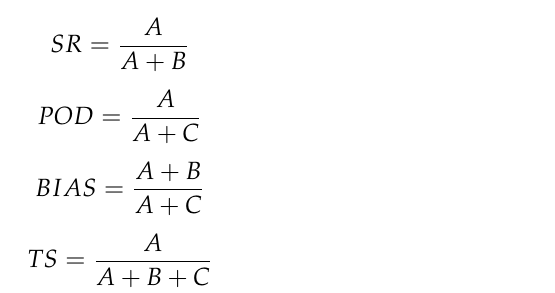
Table 1. The categorical contingency table. Observation Yes No Yes Hits False alarms Forecast No Misses Correct